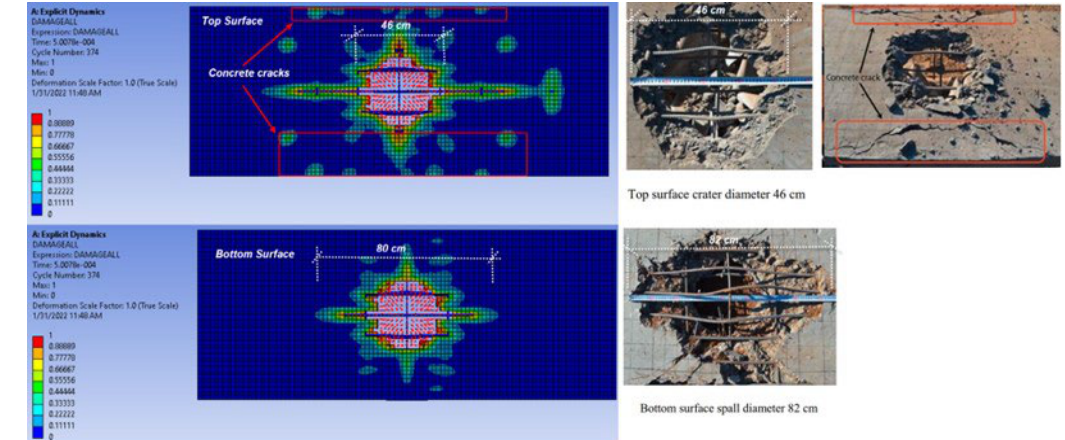
Figure 8 – Comparison between experimental damage & FE damage of NRC-2